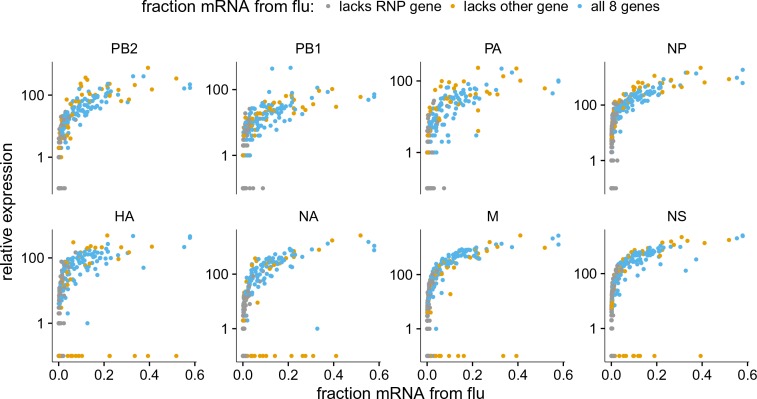
Like panel (A), but excludes coinfected cells with mixed viral barcodes.The normalized expression of each viral gene as a function of the fraction of total mRNA derived from virus, excluding cells that were annotated as coinfected based on the presence of both viral barcodes.